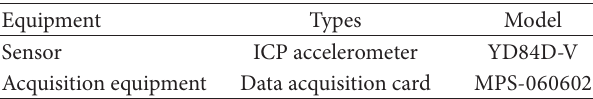
Table 5: Data acquisition equipment